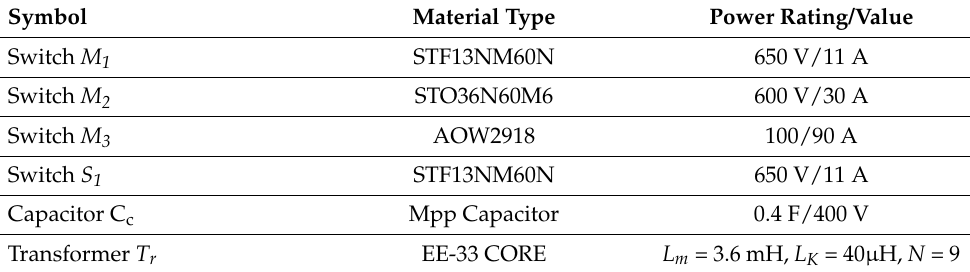
Table 6. Key components of the proposed hybrid